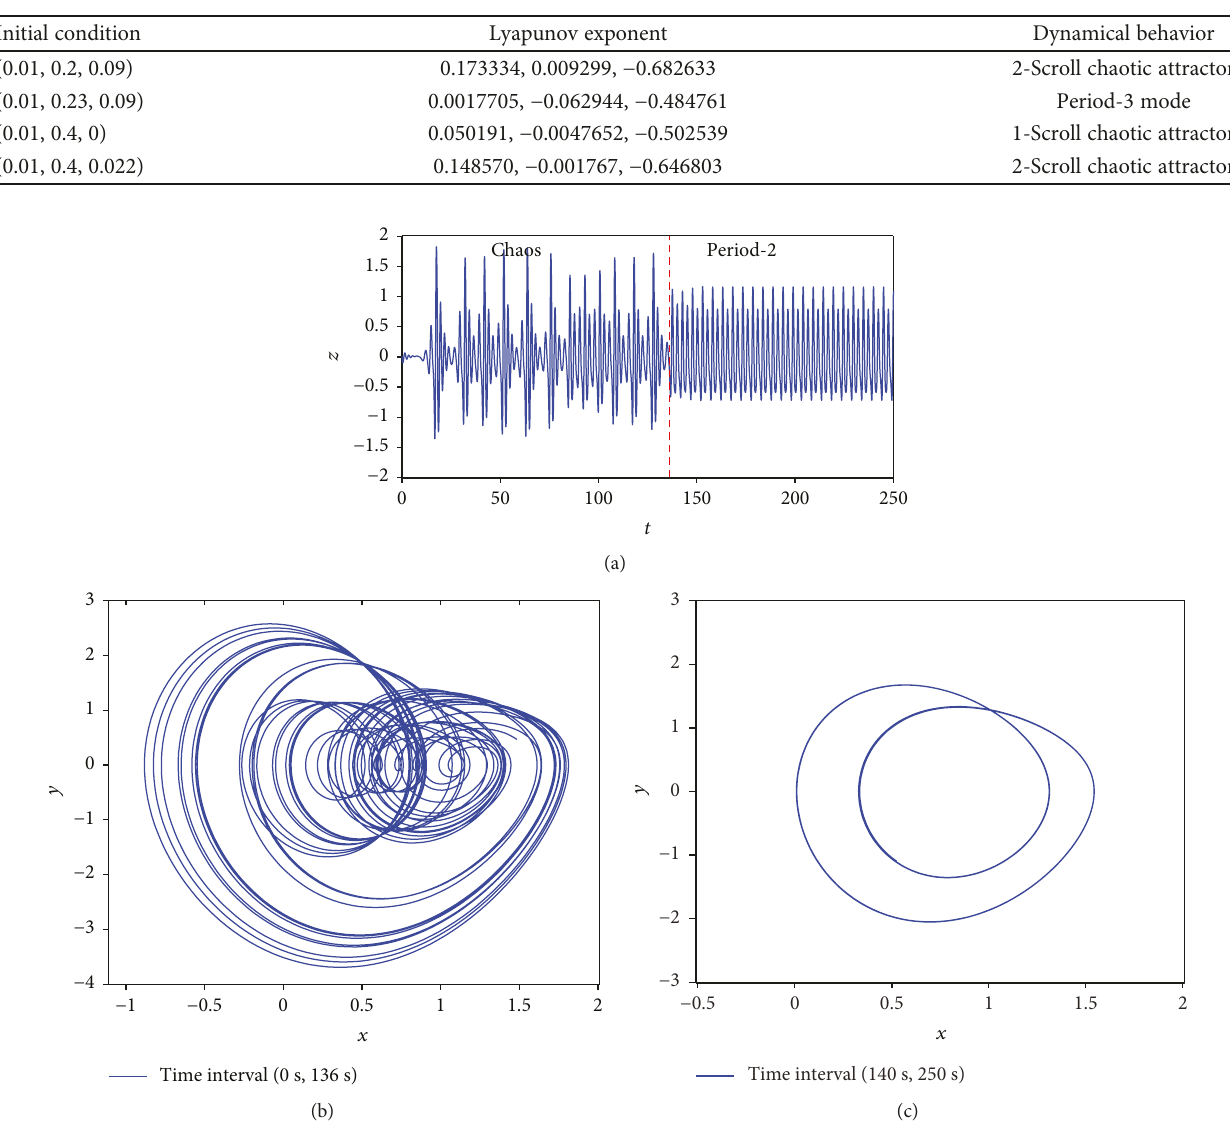
Figure 9: (a) Time-domain waveform of variable z in the region of (0 s, 250 s); (b) the phase portrait in time interval of (0 s, 136s); (c) the phase portrait in time interval of (140s, 250